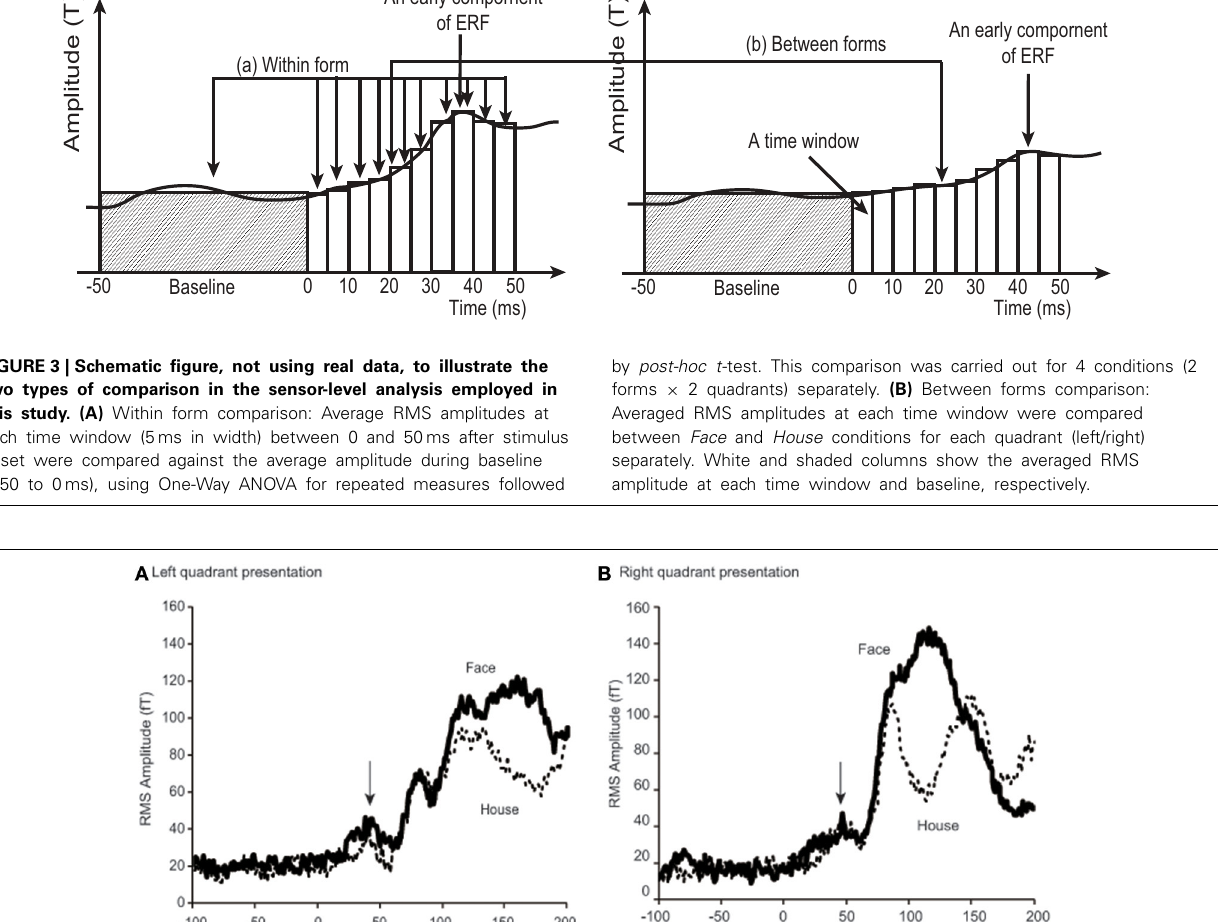
FIGURE 4 | Time courses of averaged RMS amplitude across 18 subjects. Each condition shows a peak at around 40ms after stimulus onset. For left quadrant presentation (A) , RMS of amplitude for Face stimuli (bold lines) was larger than for House stimuli (broken lines) not only after 100ms, but also before 50ms after stimulus onset. For right quadrant presentation (B) , the